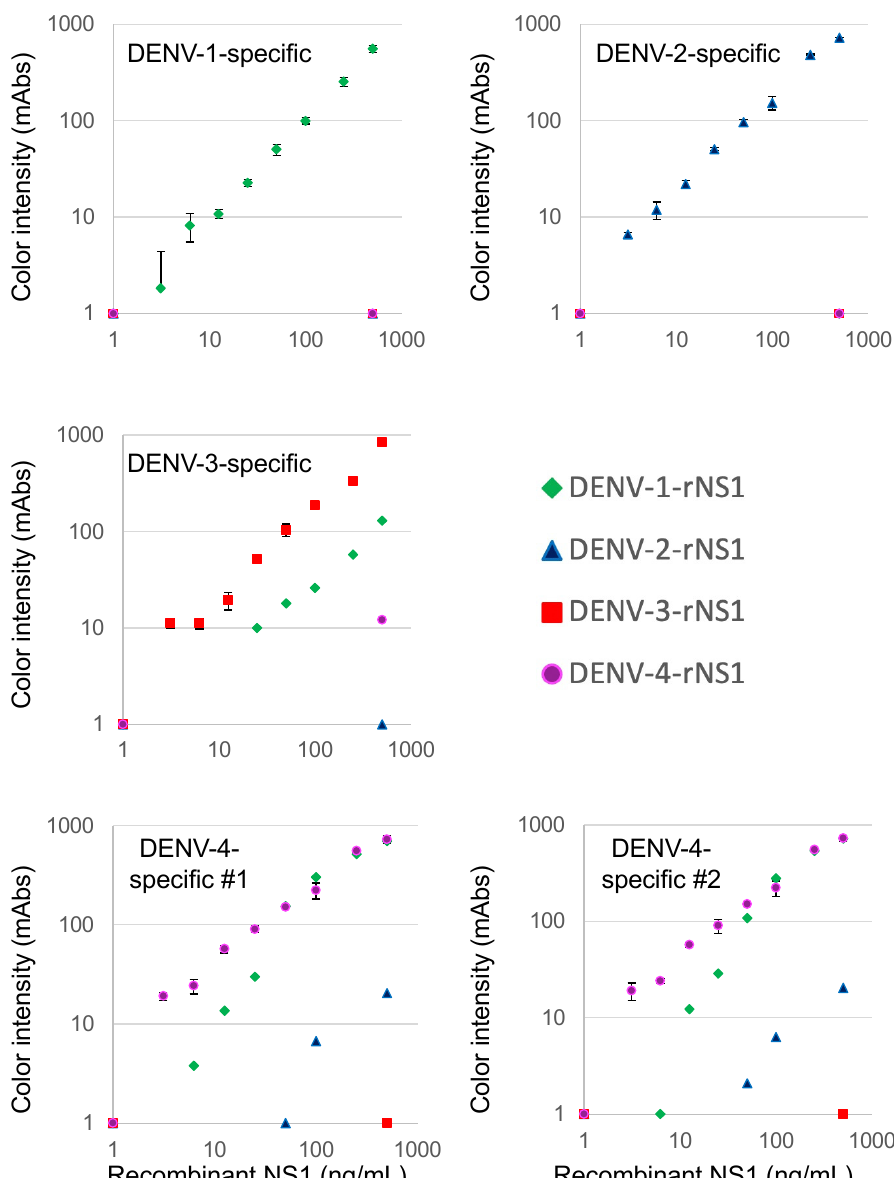
Figure 1. Evaluation of reactivity to recombinant NS1 proteins.